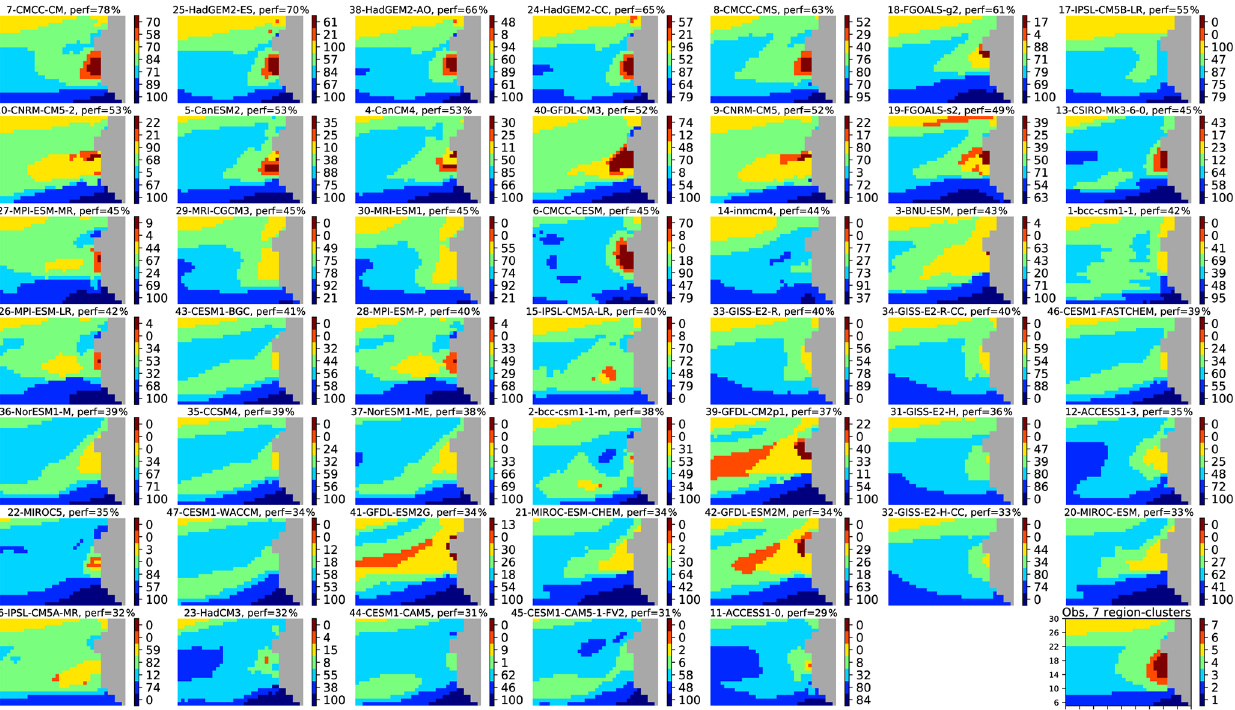
Figure 3. Projection of the 47 climate models of the CMIP5 database onto the SOM learned with ERSSTv3b climatology in the extended zone (see Fig. 1). On top of each panel, we figure the number referencing the model, its name (Table 1), and its skill given as a mean percentage (see text). The models are ordered according to their skill in decreasing order. The seven region clusters (or SOM clusters) are defined by applying an HAC to the SOM output learned with the observation field. They are represented by different colors. The numbers in the color bar on the right of each panel represent the skill for each region cluster. The observation field is shown in the bottom right panel and the numbers in front of the color bar reference the region